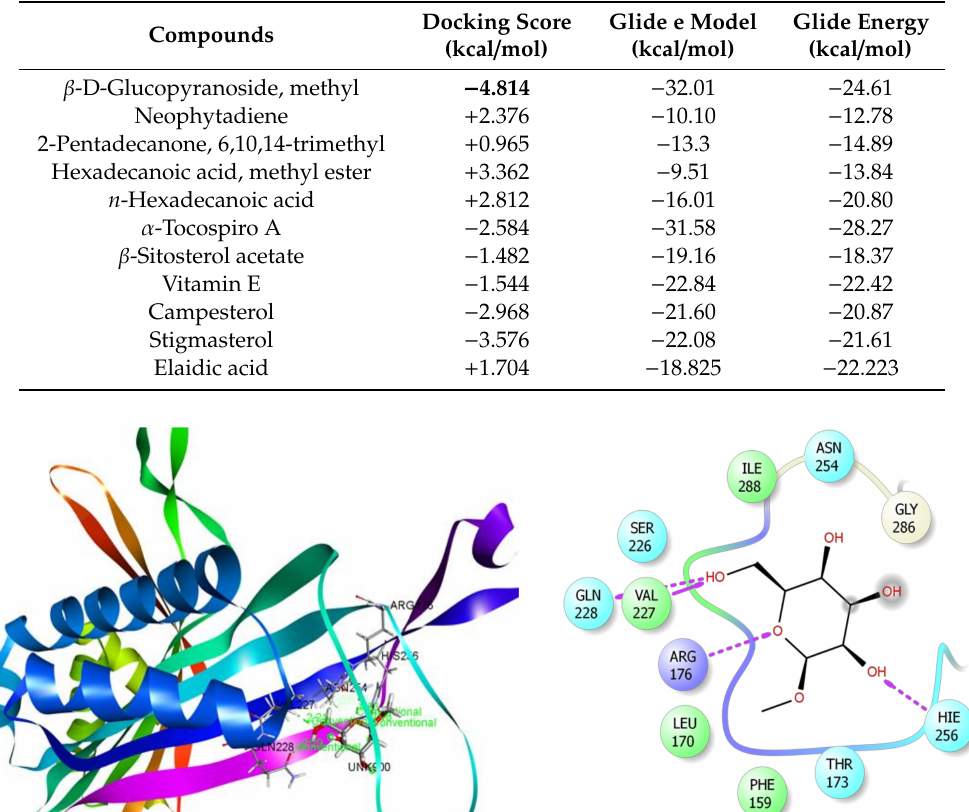
Table 6. Docking score of the identified compounds against xanthine oxidoreductase (pdb: 1R4U) for antioxidant activity. Bold indicate the highest docking score.